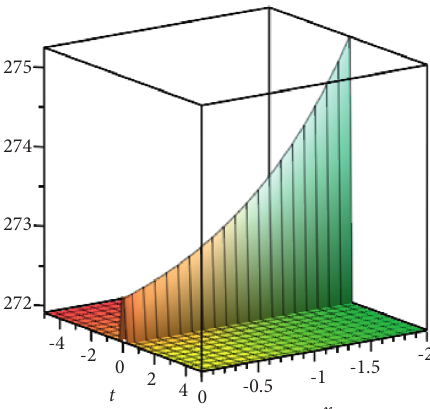
( x, t ) | when β � − 0 . 05 , 4